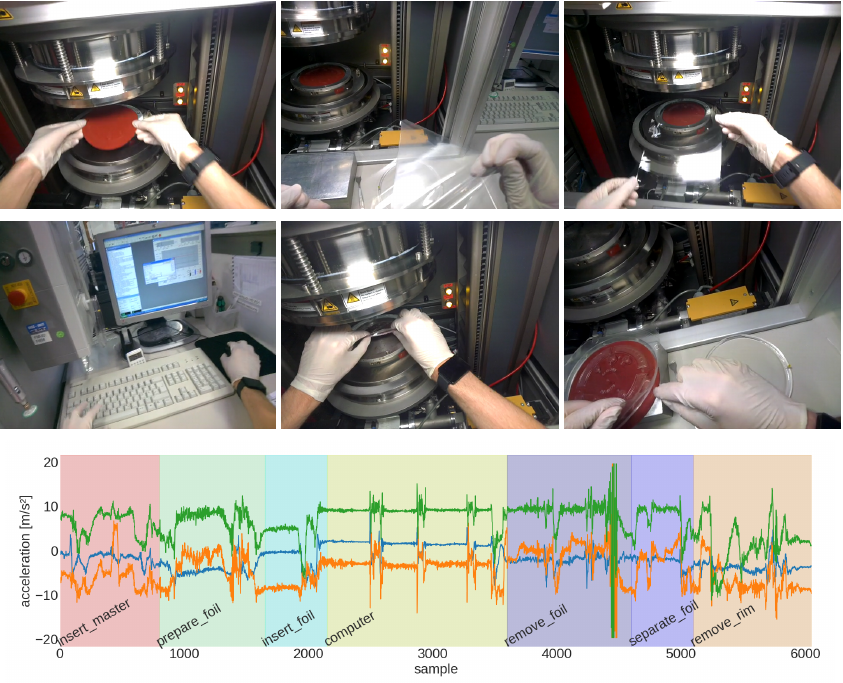
Figure 3. The third dataset in this paper uses video frames from a Google Glass recording of steps in a thermoforming process, combined with IMU data from the wrist and Google Glass. Shown here are six distinct stills from the Google Glass video showing different actions (top) and wrist accelerometer data from the same recording (bottom time-series plot), with the process steps marked as background